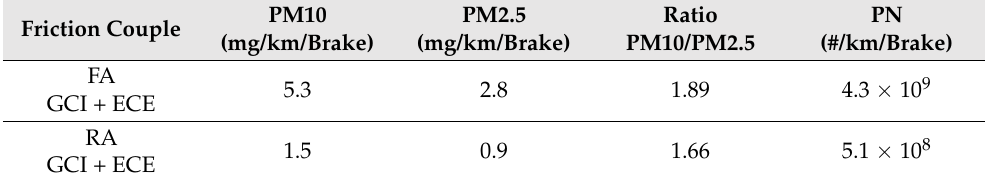
Table 5. Emission factors of the C-segment vehicle for front and rear-axle disc brake.